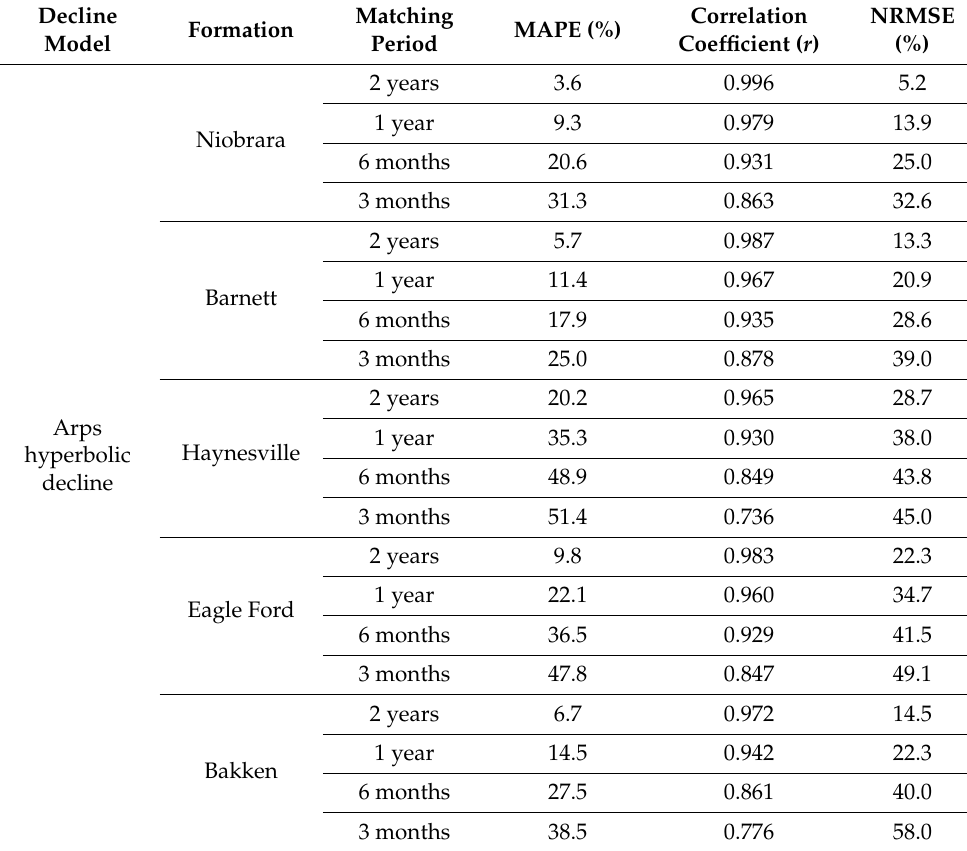
Table 5. Results from production history matching on all wells from each formation using different production data periods with the Arps hyperbolic decline